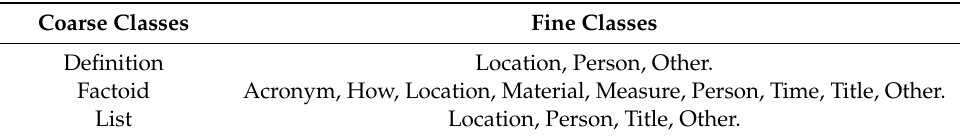
Table 1. Taxonomy of question